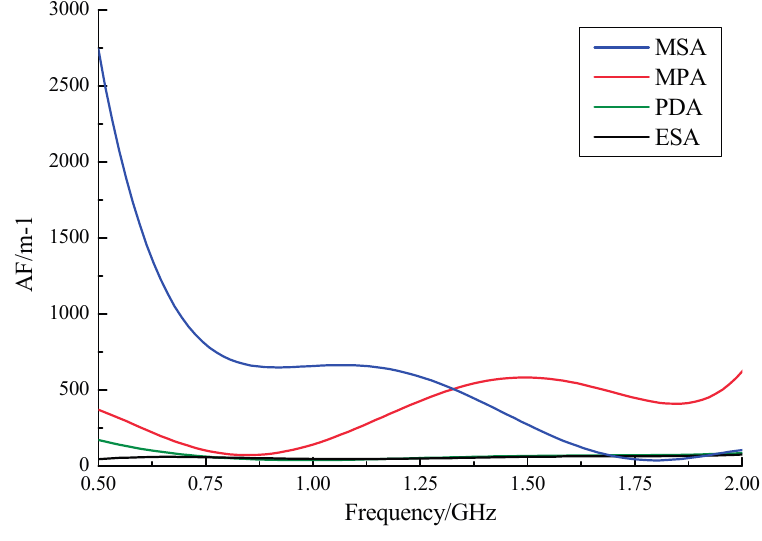
Figure 13. Calibration curves of antenna factors for four antenna